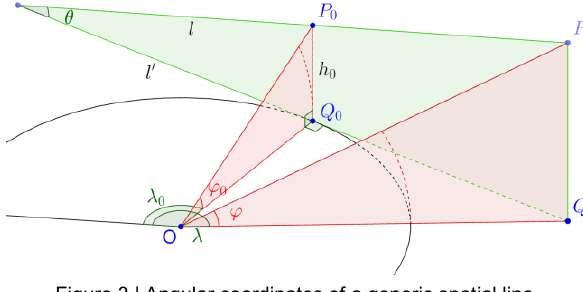
Figure 3 | Angular coordinates of a generic spatial line.